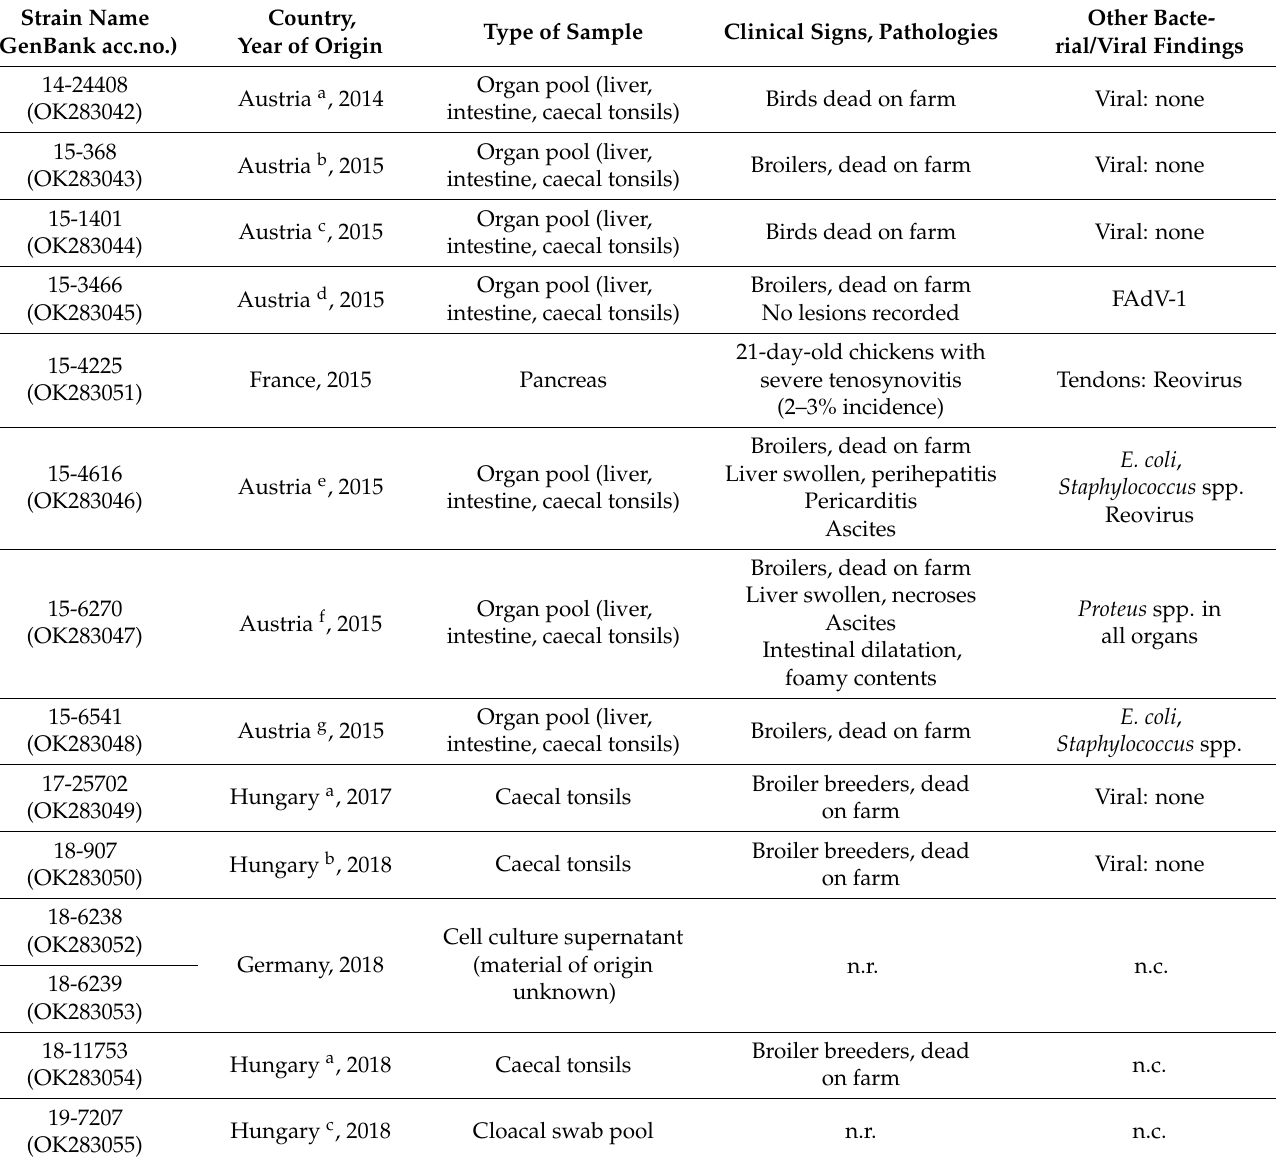
Table 1. FAdV-B isolates investigated in this